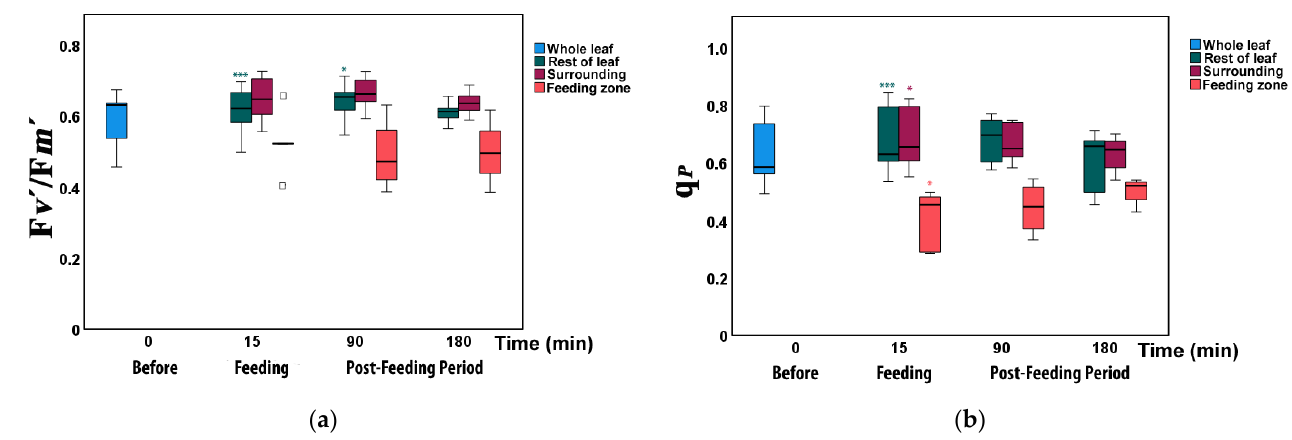
Figure 7. Changes in ( a ) efficiency of open PSII reaction centers (F v ’/F m ’) and ( b ) fraction of open PSII reaction centers (q p ) in different zones of tomato leaflets before (0 min), immediately after (15 min), and post-feeding period, 90 and 180 min after insect feeding. Symbols, box plots, and significances are as in Figure 3.